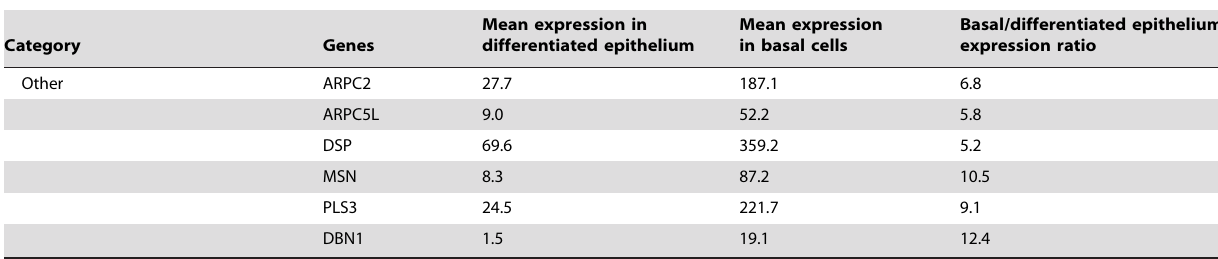
1 Genes identified by GATHER KEGG categories (Table 2, Table S3), Gene Ontology categories (Table 3, Table S5), and/or Canonical Pathways (Table 4, Table S6).